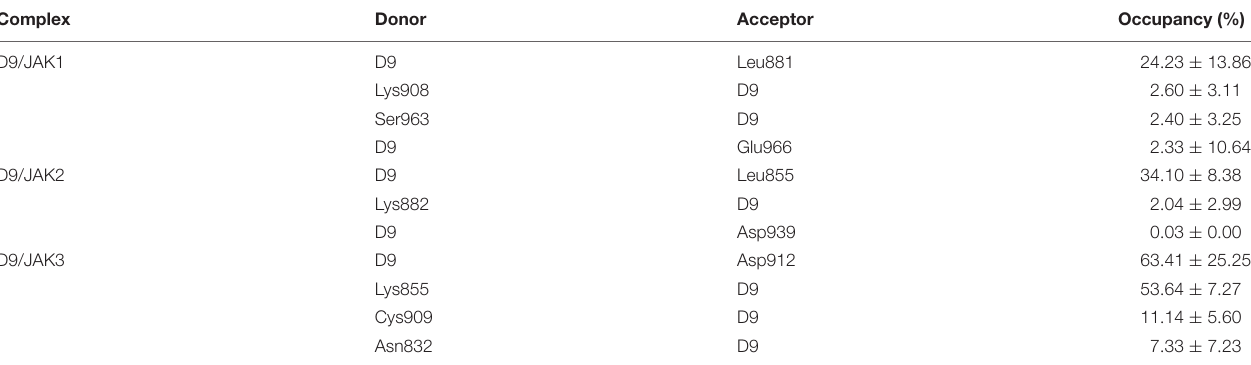
TABLE 6 | The analysis of the H-bonds occupancy during the MD simulation process for D9/JAKs. Complex Donor Acceptor D9/JAK1